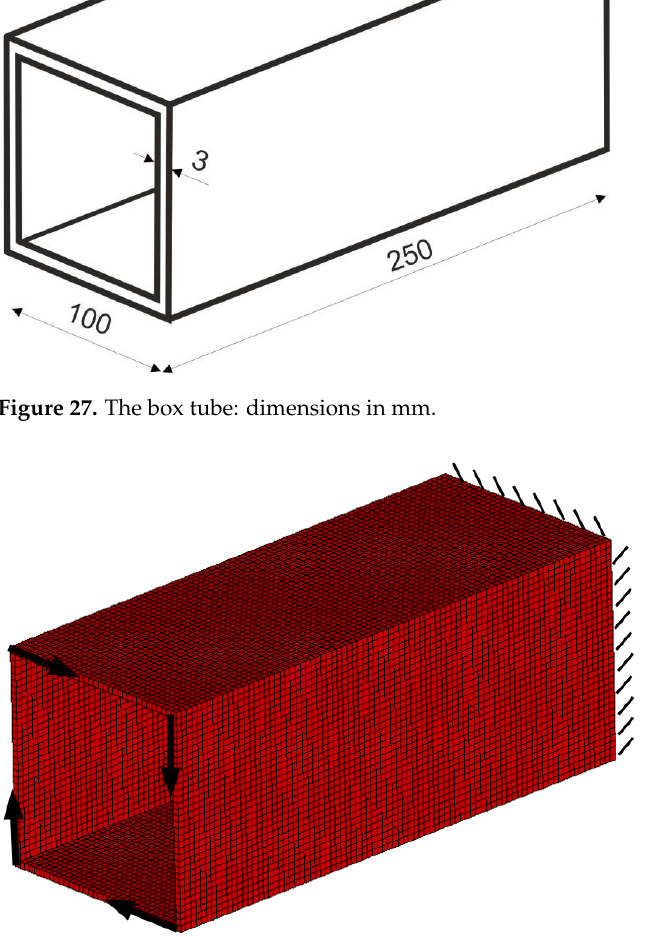
Figure 28. The design domain, loads, and supports of the box tube.